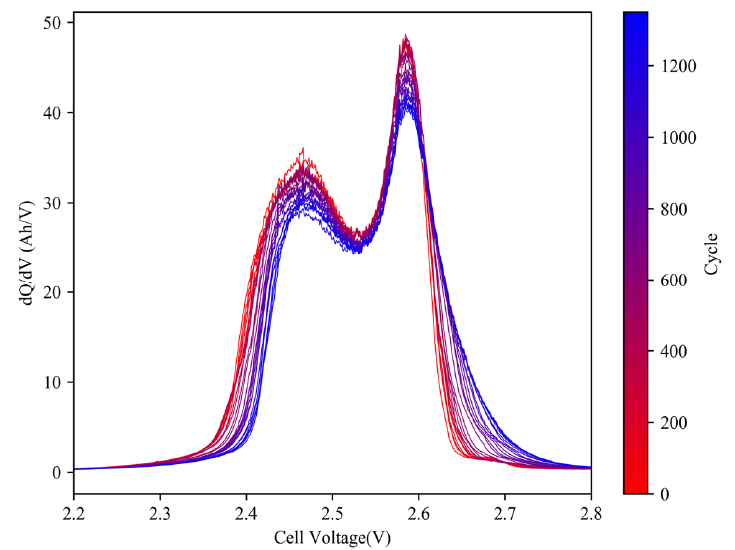
Figure 7. Evolution of IC curves (0.05 C) of cell #7 during aging cycles.